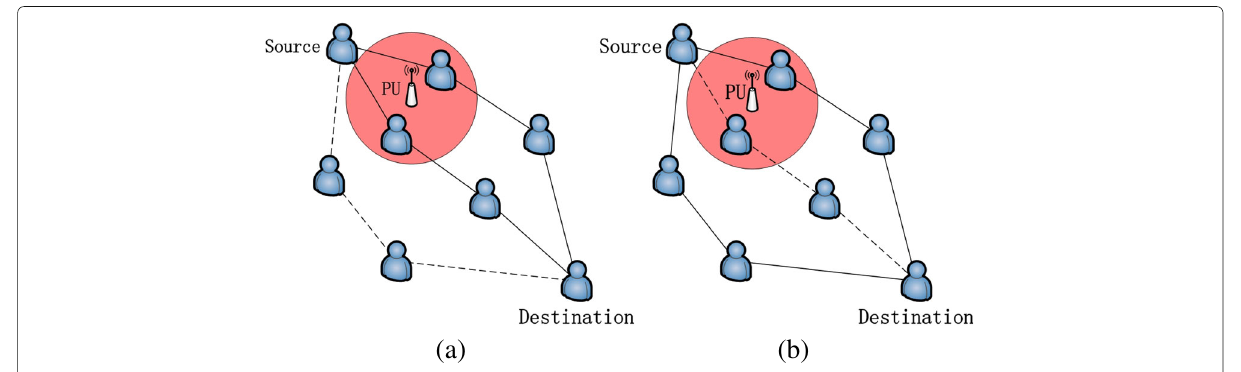
Fig. 1 Difference between close routes and non-close routes. a Close routes. b Non-close routes